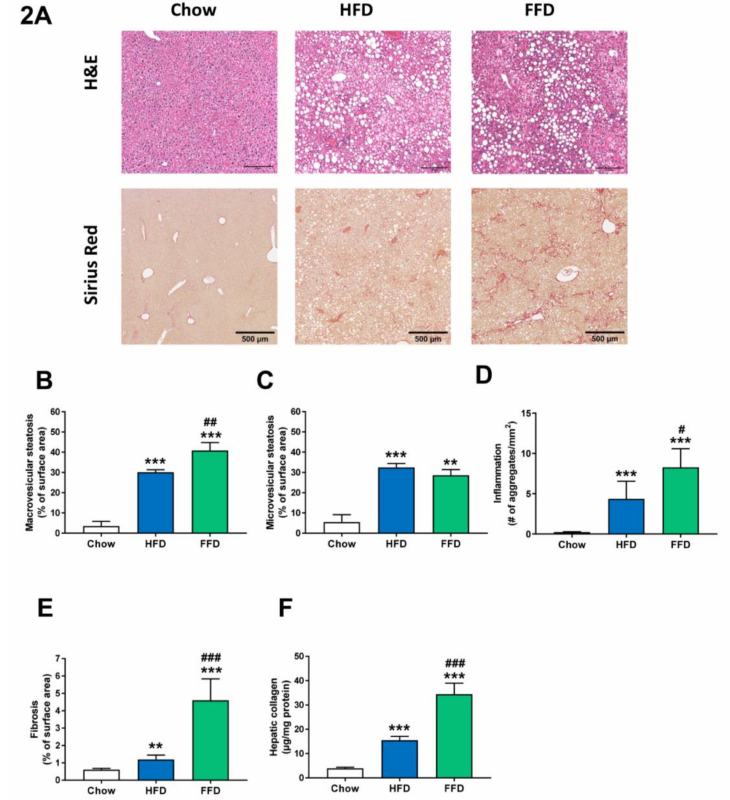
Figure 2. Representative images of liver cross-sections stained with hematoxylin and eosin (H&E) or Sirius Red ( A ) and quantitative analysis ( B – F ) from Ldlr − / − .Leiden mice fed a healthy chow diet or fed a high-fat diet (HFD) containing lard or a fast food diet (FFD) containing milk fat for 28 weeks. Macrovesicular ( B ) and microvesicular ( C ) steatosis as a percentage of total liver area, inflammation as number of inflammatory aggregates per mm 2 microscopic field ( D ), and hepatic fibrosis were analyzed as percentage Sirius Red of surface area ( E ) or biochemically analyzed hepatic collagen / mg protein ( F ). Values represent mean ± SEM for ≥ 8 mice per group. ** p < 0.01 and *** p < 0.001 vs. chow; # p < 0.05, ## p < 0.01 and ### p < 0.001 FFD vs.